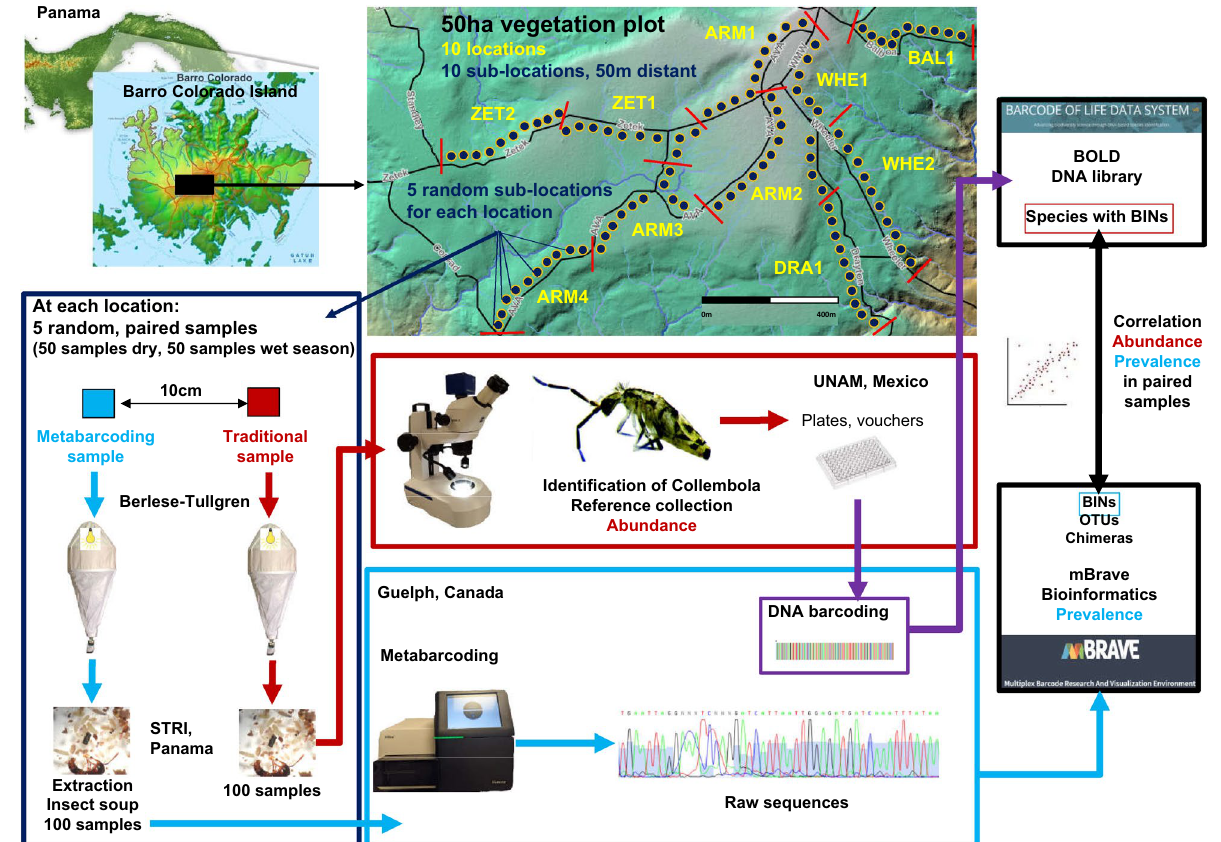
Figure 1. Summary diagram illustrating the workflow of samples for springtails. The black square in the BCI map indicates the location of the 50 ha plot. Traditional samples of ants and termites were processed at STRI in Panama. The Panama and BCI maps are freely available at https:// nsf. gov/ news/ mmg/ mmg_ disp. jsp? med_ id= 74874 &from. Map from the 50 ha plot is also freely available at https:// strid ata- si. opend ata. arcgis. com/ maps/ SI:: barro- color ado- island- topog raphic- webmap/ explo re? locat ion=9. 157000% 2C- 79. 848900% 2C14.